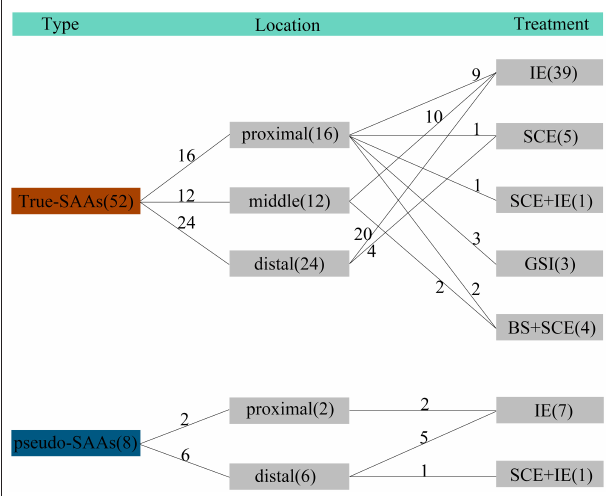
FIGURE 2 | The characteristics of SAAs and treatment methods adopted in this study. There were 52 true SAAs included, and 16 SAAs among them located at the proximal parent artery, which received treatment of IE ( n = 9), SCE ( n = 1), SCE + IE ( n = 1), GSI ( n = 3), and BS + SCE ( n = 2), respectively. For SAAs located at the middle parent ( n = 12), they received IE ( n = 10) and BS + SCE ( n = 2), respectively. For SAAs located at the distal parent artery ( n = 24), they received IE ( n = 20) and SCE ( n = 4), respectively. There were 8 pseudo-SAAs included and the 2 SAAs located at the proximal side both received IE treatment. The remained 6 pseudo-SAAs received IE ( n = 5) and SCE + IE ( n = 1) treatment, respectively. IE, isolation